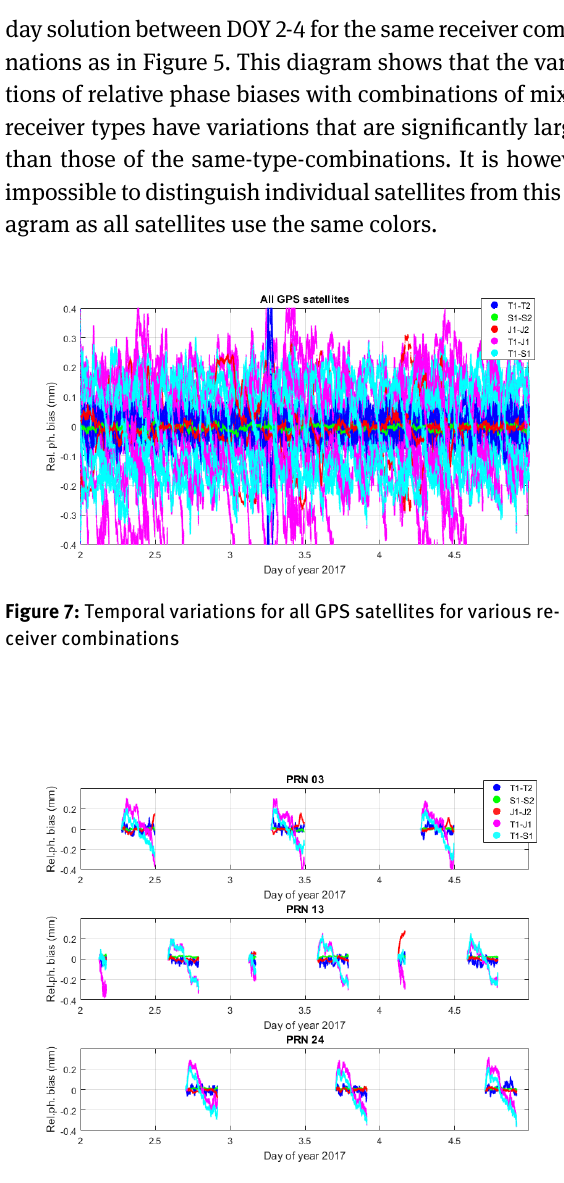
Figure 8: Temporal variations for 3 representative GPS satellites for various receiver